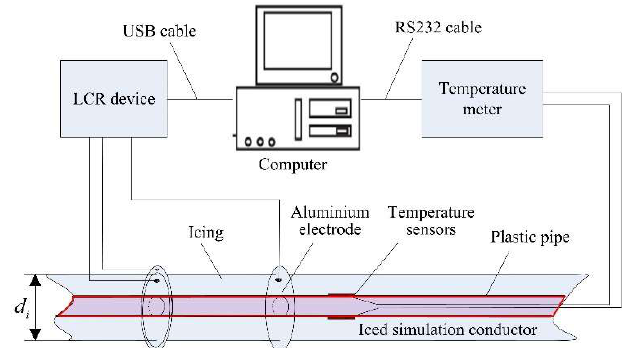
Figure 4. The measurement of the dielectric constant of an icing sample.